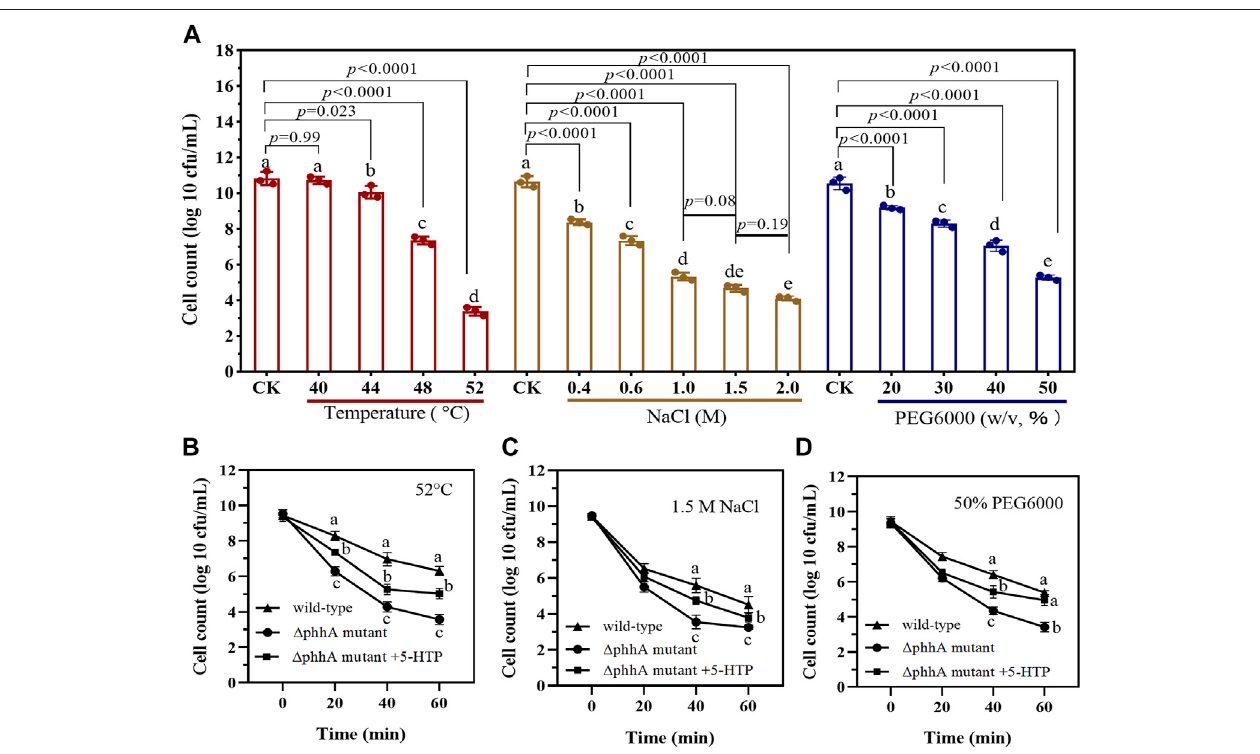
FIGURE 5 | The tolerance to different abiotic stress for wild-type and Δ phhA mutant P. fl uorescens . (A) The cell count (log number of cells per milliliter) of wild-type strain when cultured in LB medium treated with varying degrees of high temperature, NaCl, or drought stress. Cells were grown for 16 h, and the growth at each condition was monitored using the plate counting method after appropriate dilutions. (B) Survival (log number of cells per milliliter) of Δ phhA mutant strain exposed to 52 ° C when cultured in LB medium supplemented with 5-HTP or not. (C) Survival (log number of cells per milliliter) of Δ phhA mutant strain exposed to 1.5 M NaCl when cultured in LB medium supplemented with 5-HTP or not. (D) Survival (log number of cells per milliliter) of Δ phhA mutant strain exposed to 50% PEG6000 when culturedinLBmedium supplementedwith5-HTPornot.Each datapoint represents themean ± standarddeviation( n (cid:2) 3).Differentletters indicatesigni fi cantdifference with the two-tailed Student ’ s t -test compared to the control in each treatment or time